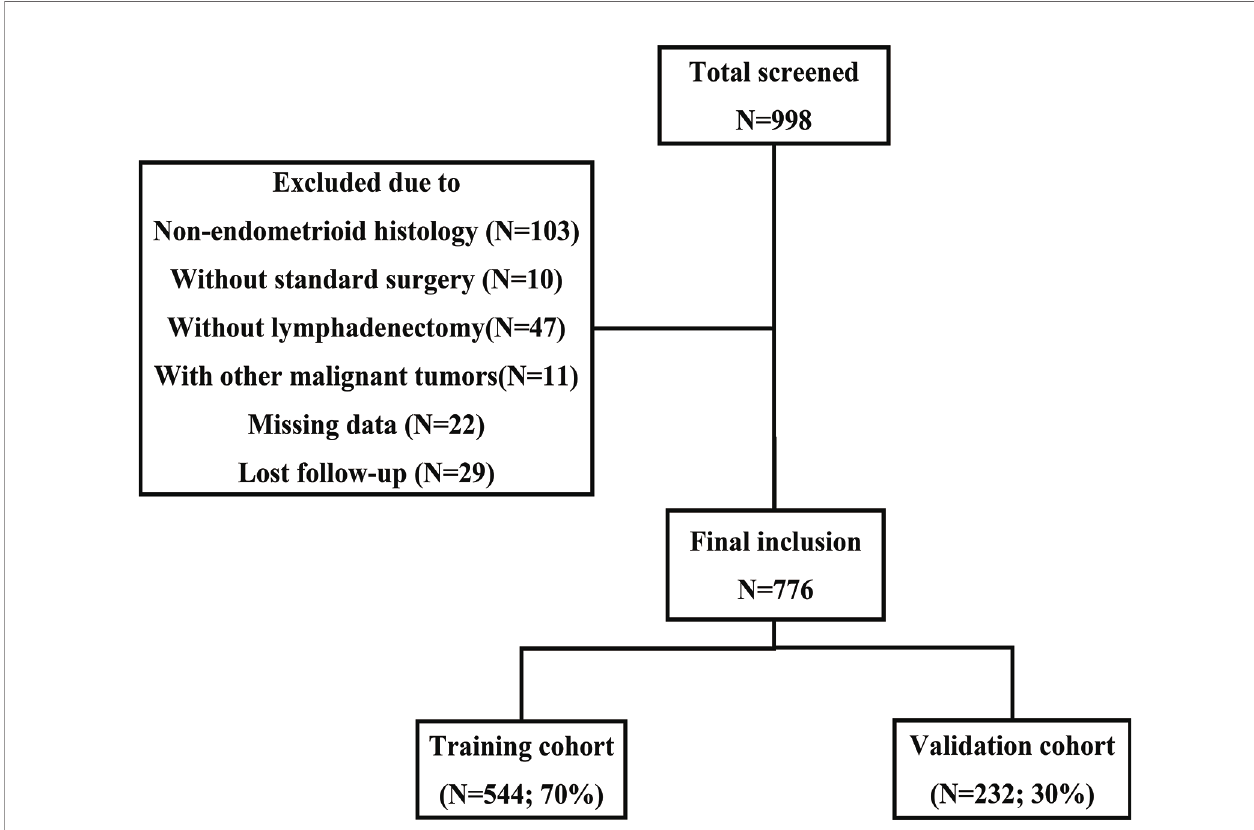
FIGURE 1 | Flowchart of patient